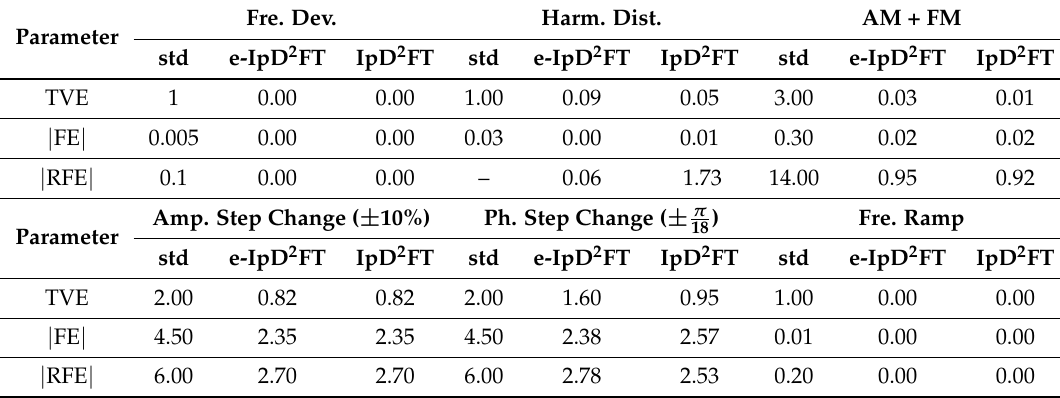
Table 3. Canonical test results and the corresponding thresholds in the standard. The Hanning window is adopted in the e-IpD 2 FT and IpD 2 FT. The observation window is three cycles long. The results of the amplitude step change test are expressed in nominal cycles. In other tests, the TVEs (%), | FE | s (Hz) and | FE | s (Hz/s) are given in maximum